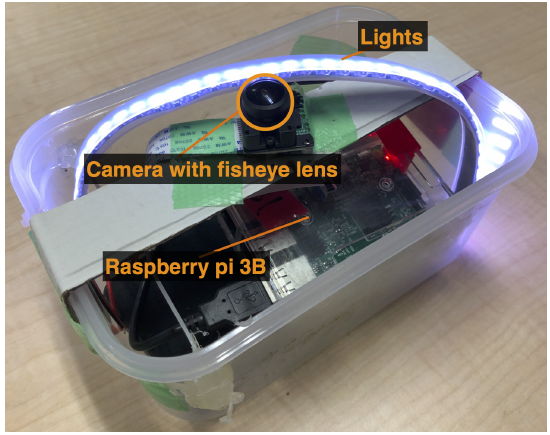
Figure 9. A prototype